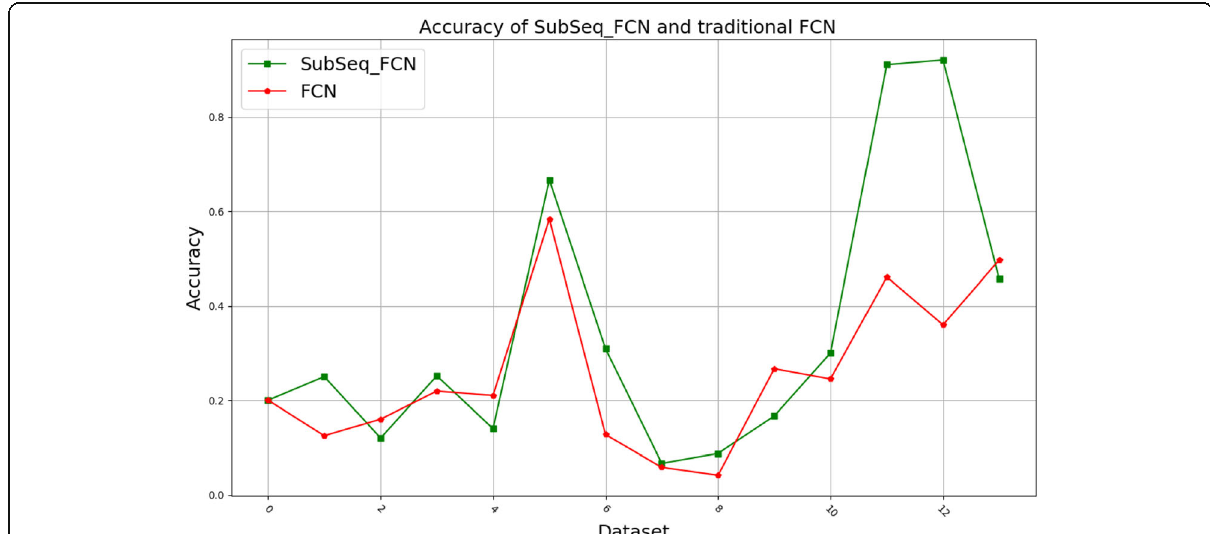
Fig. 9 The accuracy of the original sequence and feature subsequence on